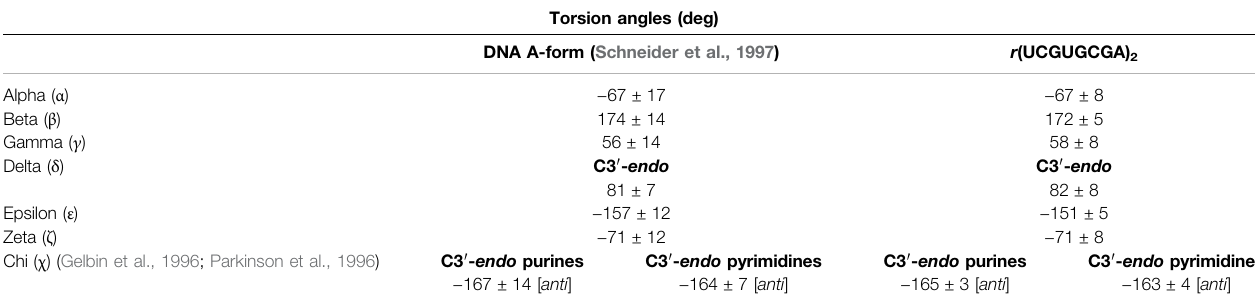
TABLE 2 | Universal torsion angles for the A-helix and torsion angles (Gelbin et al., 1996; Parkinson et al., 1996; Schneider et al., 1997) in the r(UCGUGCGA) 2 duplex calculated using the 3DNA server, v2.4.3-2019apr06 (Lu and Olson, 2003; Li et al., 2019). Torsion angles